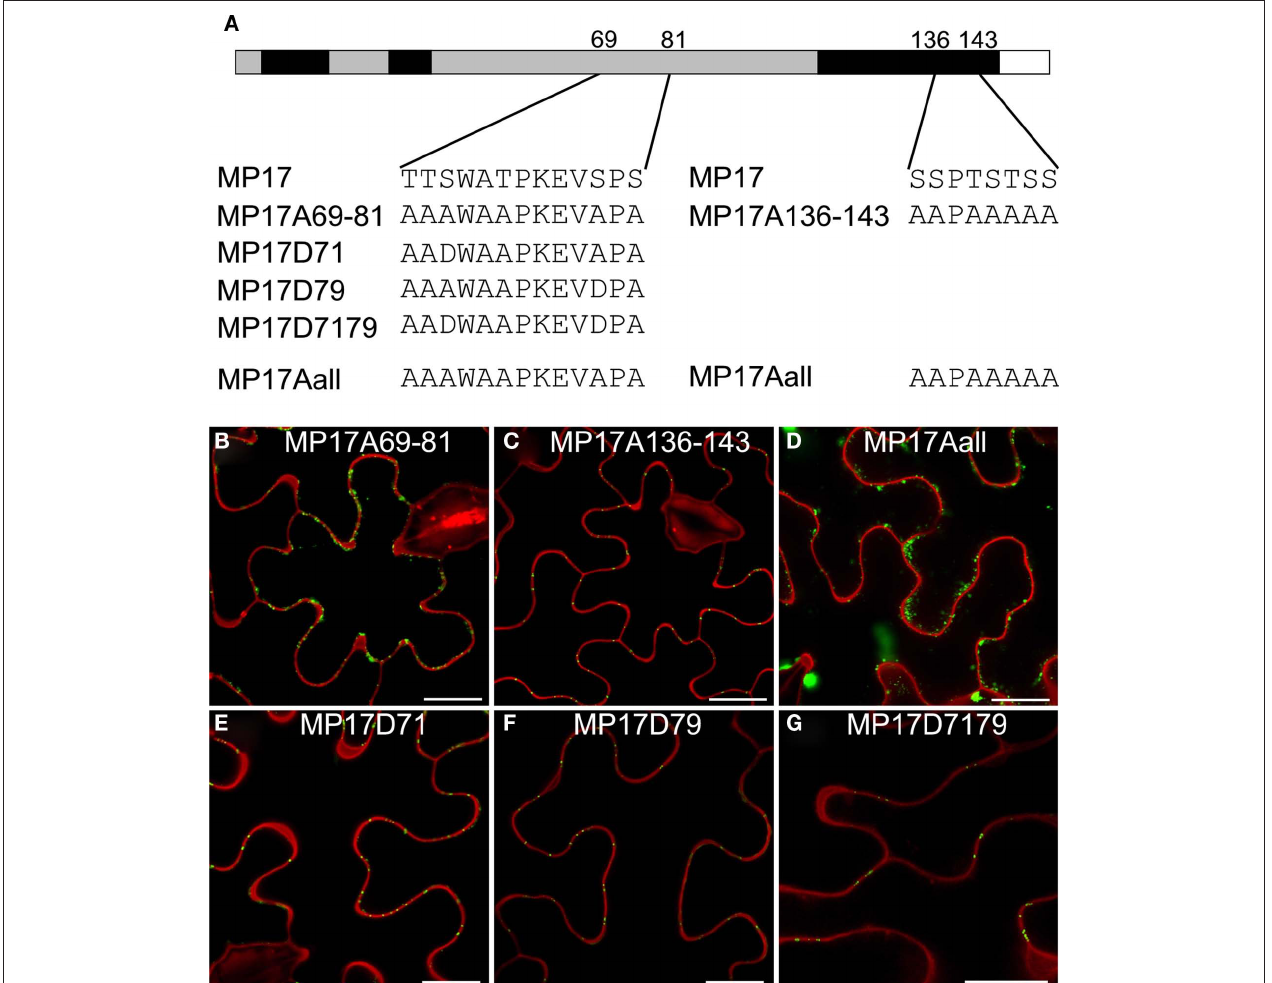
FiguRe 6 | impact of MP17 phosphorylation on PD targeting. (A) Amino acid changes introduced in the mutated MP 17 versions compared to wild type MP 17, position of exchanged peptides is indicated within the MP 17 polypeptide; (B–g) confocal images of the respective MP17:GFP variants transiently expressed in N. benthamiana epidermis cells; displayed are superimpositions of propidium iodide stained cell walls (red) and MP17:GFP fluorescence (green); bars represent 20 μm.